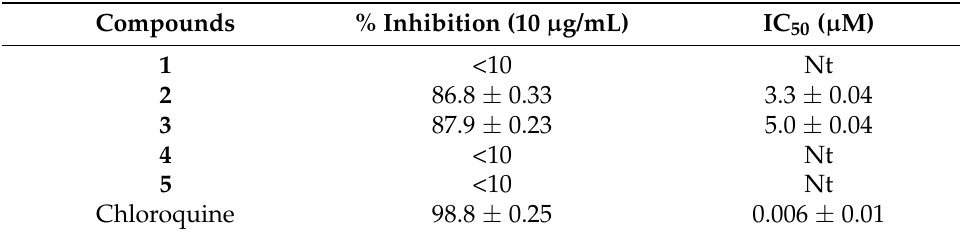
Table 5. The in vitro antiplasmodial activity of compounds 1 – 5